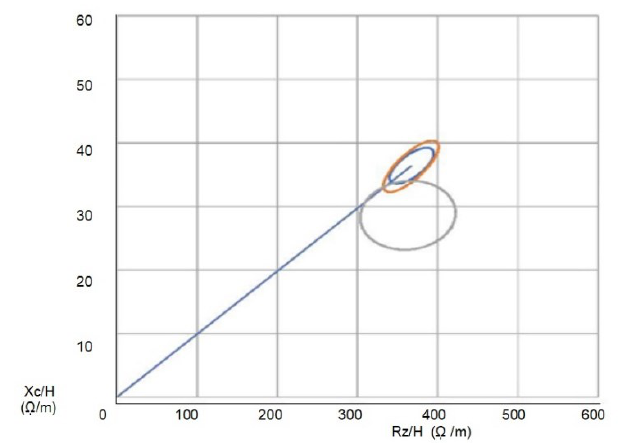
Fig.2: Female oncologic patients R + NR at T0 and T6. Female oncologic patients at T0 (baseline) compared to T6 (after 6 months): R are marked by orange color and NR by grey